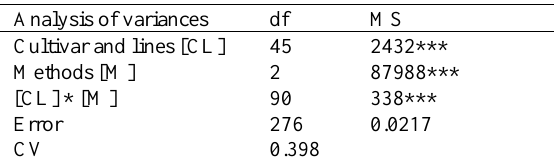
Table 2. Analysis of variance for different rapeseed lines/cultivars and the methods used to test seed secondary dormancy.